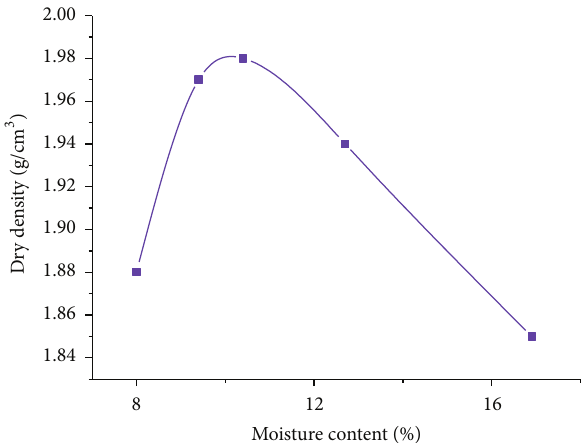
Figure 6: Moisture content and density curve.